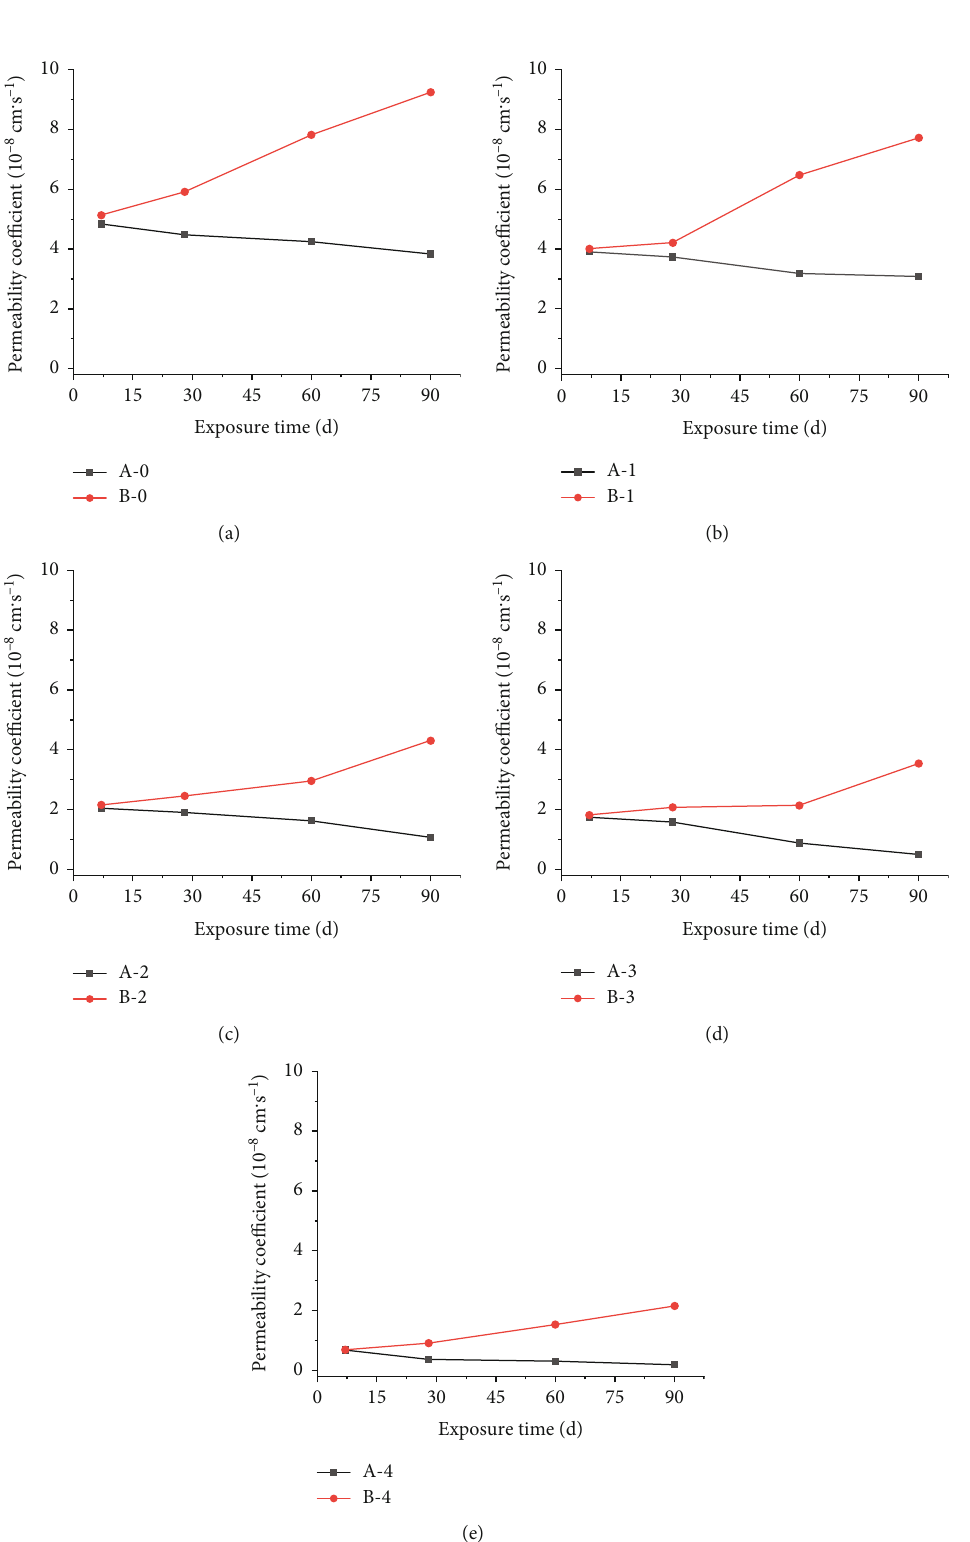
Figure 6: Comparison curve of soil-cement permeability coe ffi cient and age: (a) admixture amount of ferronickel slag is 0%; (b) admixture amount of ferronickel slag is 10%; (c) admixture amount of ferronickel slag is 20%; (d) admixture amount of ferronickel slag is 30%; (e) admixture amount of ferronickel slag is